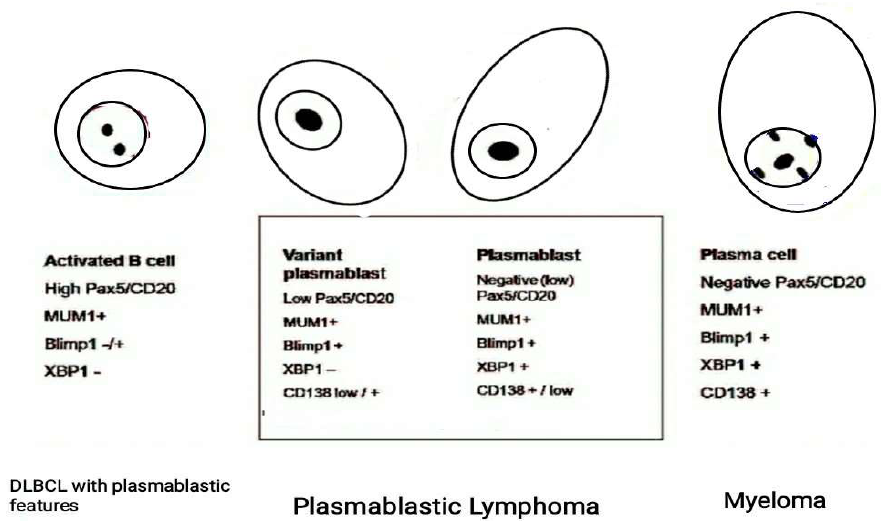
Figure 5. Use of a specific panel of monoclonal antibodies including PAX5/CD20, PRDM1/BLIMP1 and XBP1s useful to identify a plasmablastic immunophenotype in human B-cell Lymphomas. The varying extent of their expression defines lesions that ranges from large B-cell Lymphoma to plasmablastic lymphoma based on the degree of differentiation of B cells. [Modified from Montes- Moreno et al., 2010].